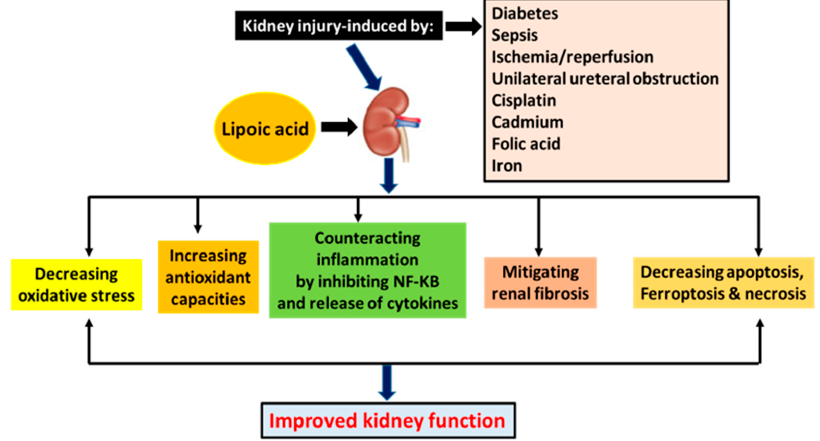
Figure 7. Mechanisms underlying lipoic acid’s role in various animal models of kidney injury discussed in the text. Lipoic acid alleviates kidney injury and improves kidney function by exerting various biological actions, as depicted in this fi gure.